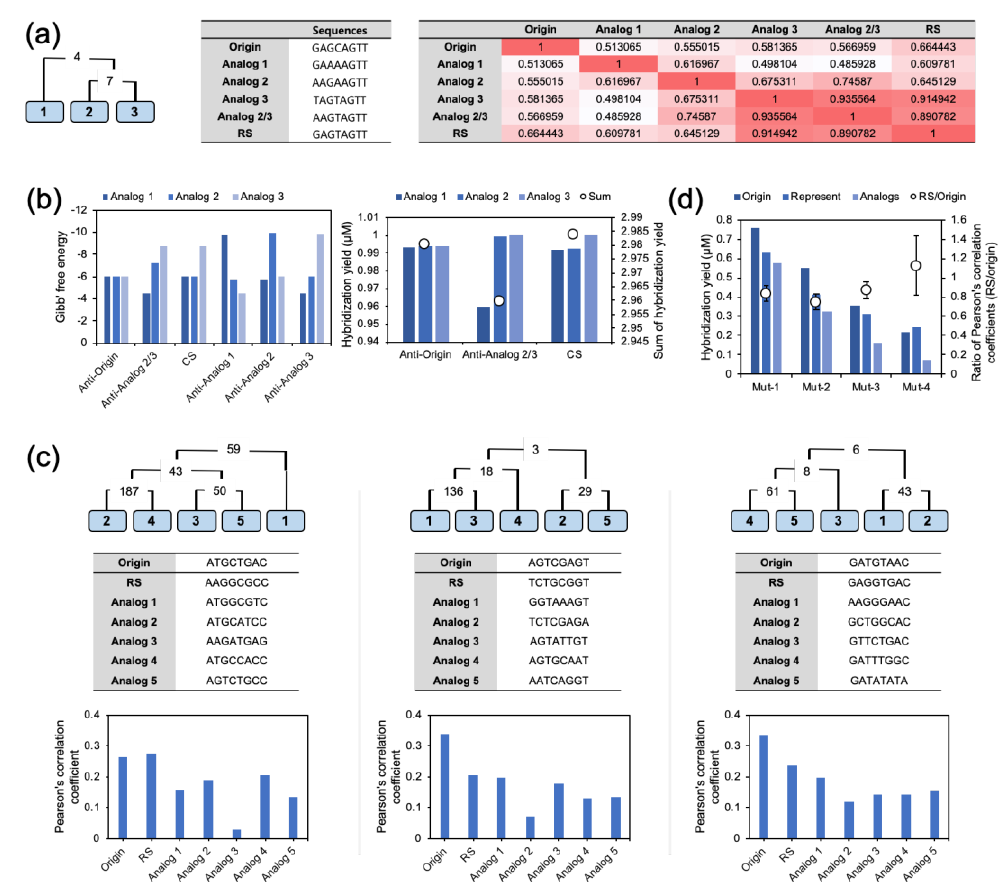
Figure 5. The sequence information of multiple analogs and its calculation tree of the RS. ( a ) Three analogs generated from a single origin with two base mutations. The order of iterative calculation was adjusted by the order of closeness. The Pearson’s correlation coefficient of the final RS also showed a modest increment against Analog 1. ( b ) The Gibbs free energies of the calculated CSs and hybridization yields against the analogs. The sum of hybridization yield was highest in the CSs. ( c ) Three sets of nucleotide clusters with five different analogs. The five analogs were generated from a single origin with three mutations. The RSs were obtained by iterative calculation, and the Pearson’s correlation coefficients were calculated for validation. ( d ) The hybridization yield and the ratio of the Pearson’s correlation coefficients of various mutation base numbers. With an increment of mutation, the functionality of the RS was becoming effective.